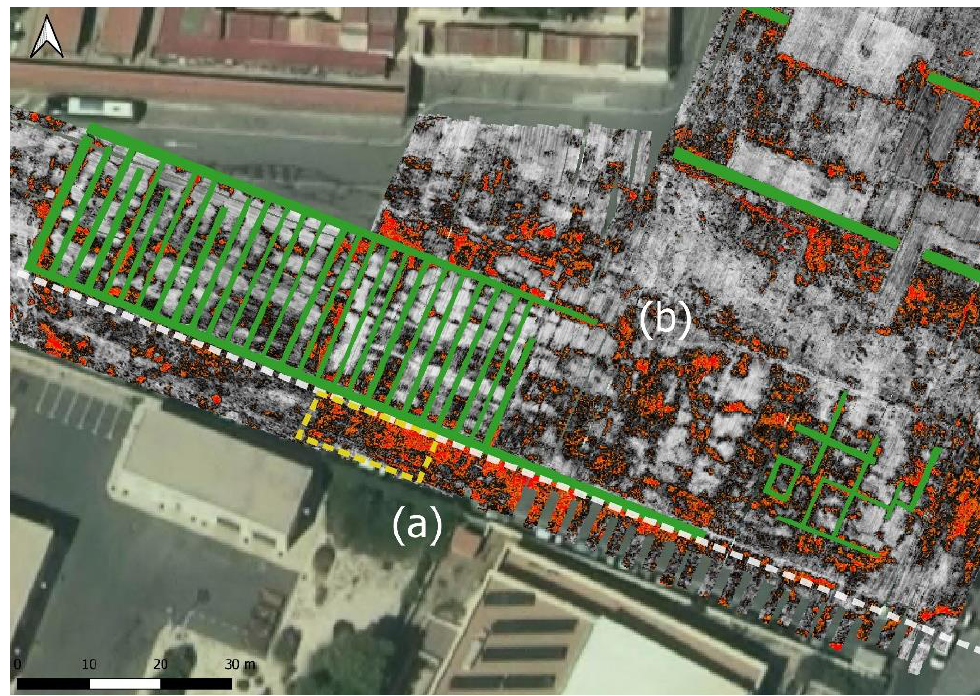
Figure 6. (a) Detail of Set 1 at the S end of the study area where the radargram signal is located (yellow dashed line) (Figure 5). (b) Detail of Set 2 where the main alignments are highlighted (green).